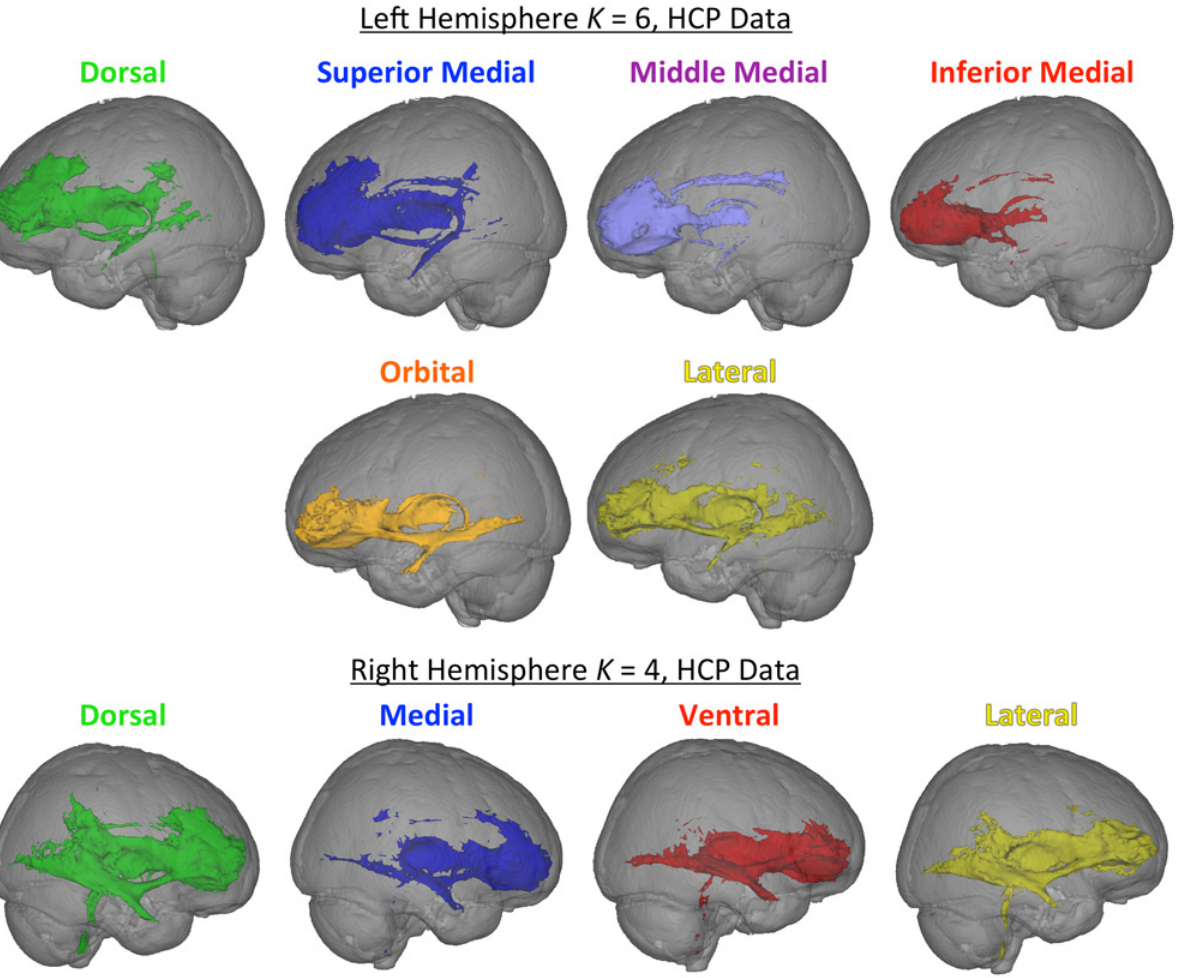
Fig 9. Tracts originating from each of the cluster in the left K = 6 solution (top) and the right K = 4 solution (bottom) for the Human Connectome Project data. Tract colors match the cluster colors in Fig 8 (average cluster maps). Tracts connecting to these clusters were present in at least 33% of the